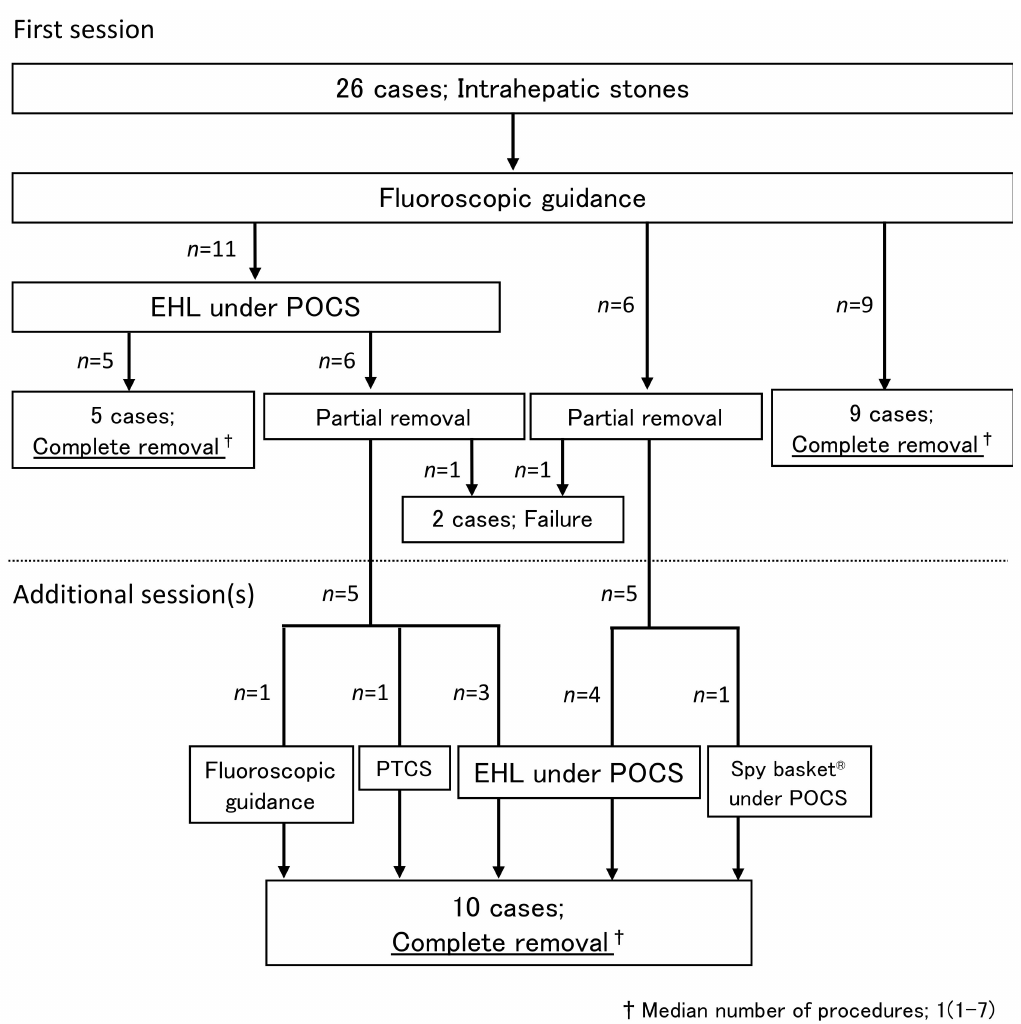
Figure 4. Progression of treatment. Abbreviations: EHL, electrohydraulic lithotripsy; POCS, peroral cholangioscopy; PTCS, percutaneous transhepatic cholangioscopic